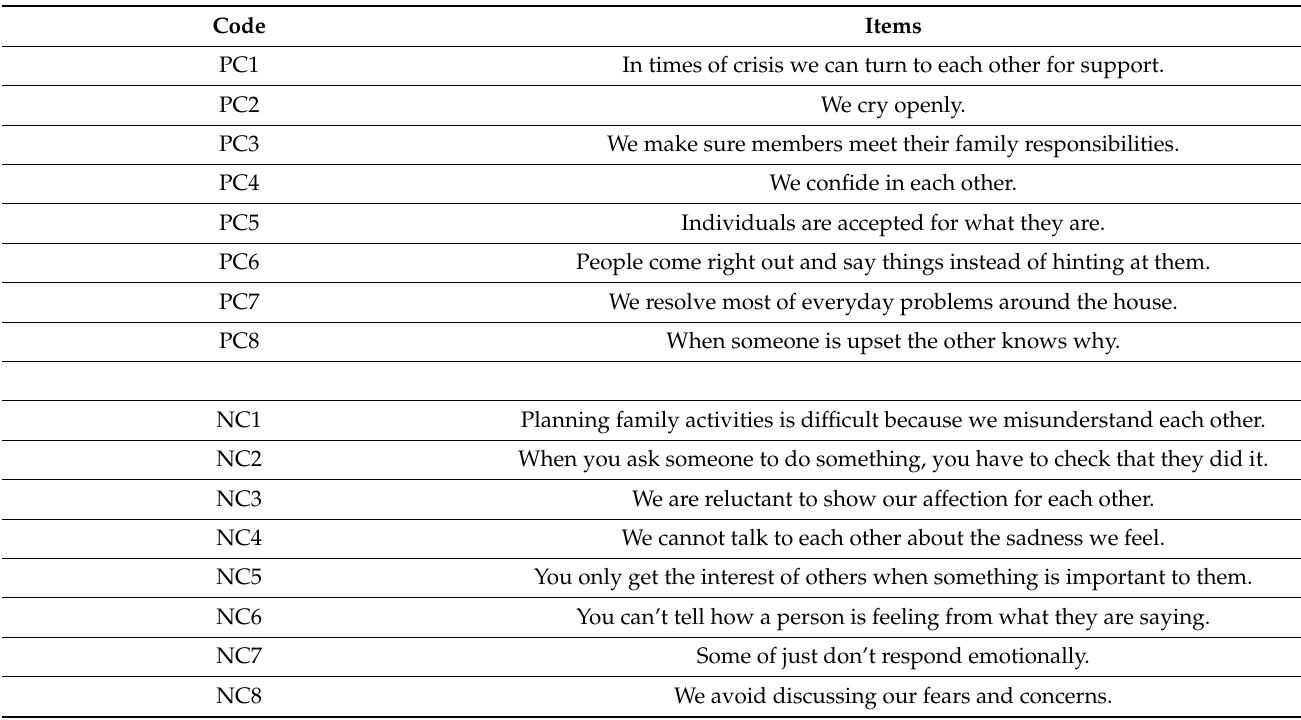
Table 2. Communication items and study